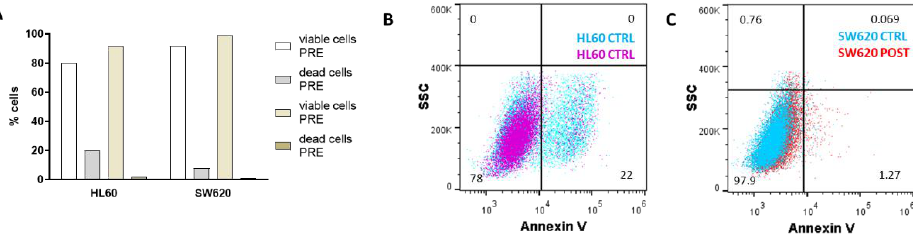
Figure 3. Viability count ( A ), apoptotic cells positive for Annexin V staining ( B , C ) in pre- and post- processed cells for both cell line HL60 and SW620, and a representative fractogram of the two ( D , E ).